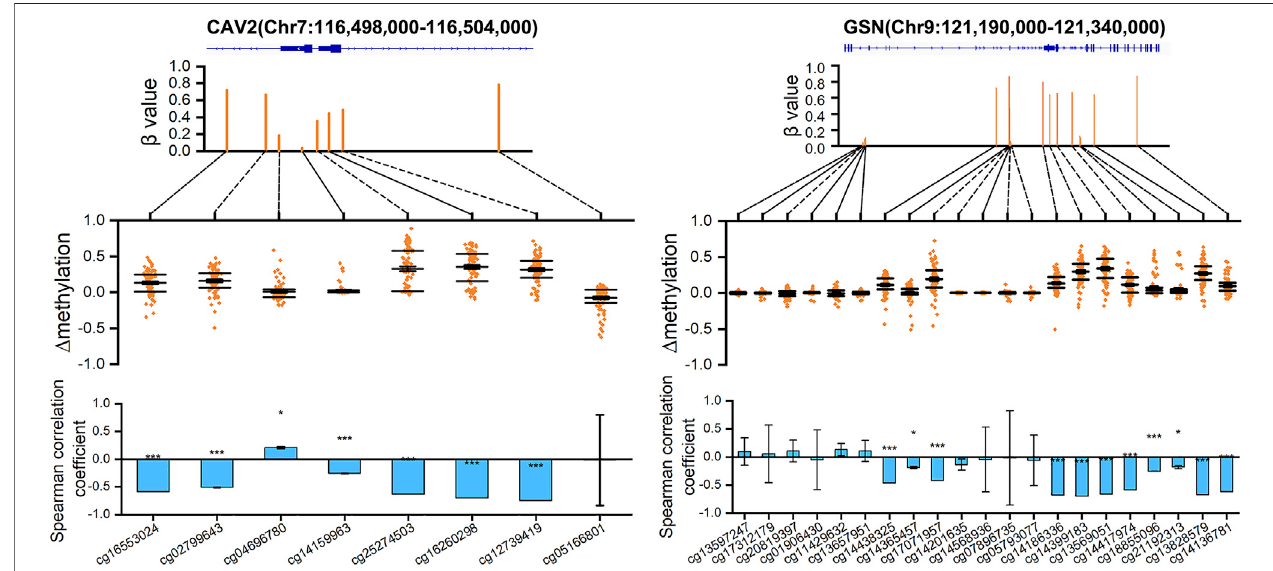
FIGURE 8 | DNA methylation distribution map of CAV2 and GSN . The scatter graph shows the Δβ level, the histogram shows the correlation coef fi cient between the DNA methylation of each probe and the gene expression value ( p -values were shown as: * p < 0.05; ** p < 0.01; *** p < 0.001).